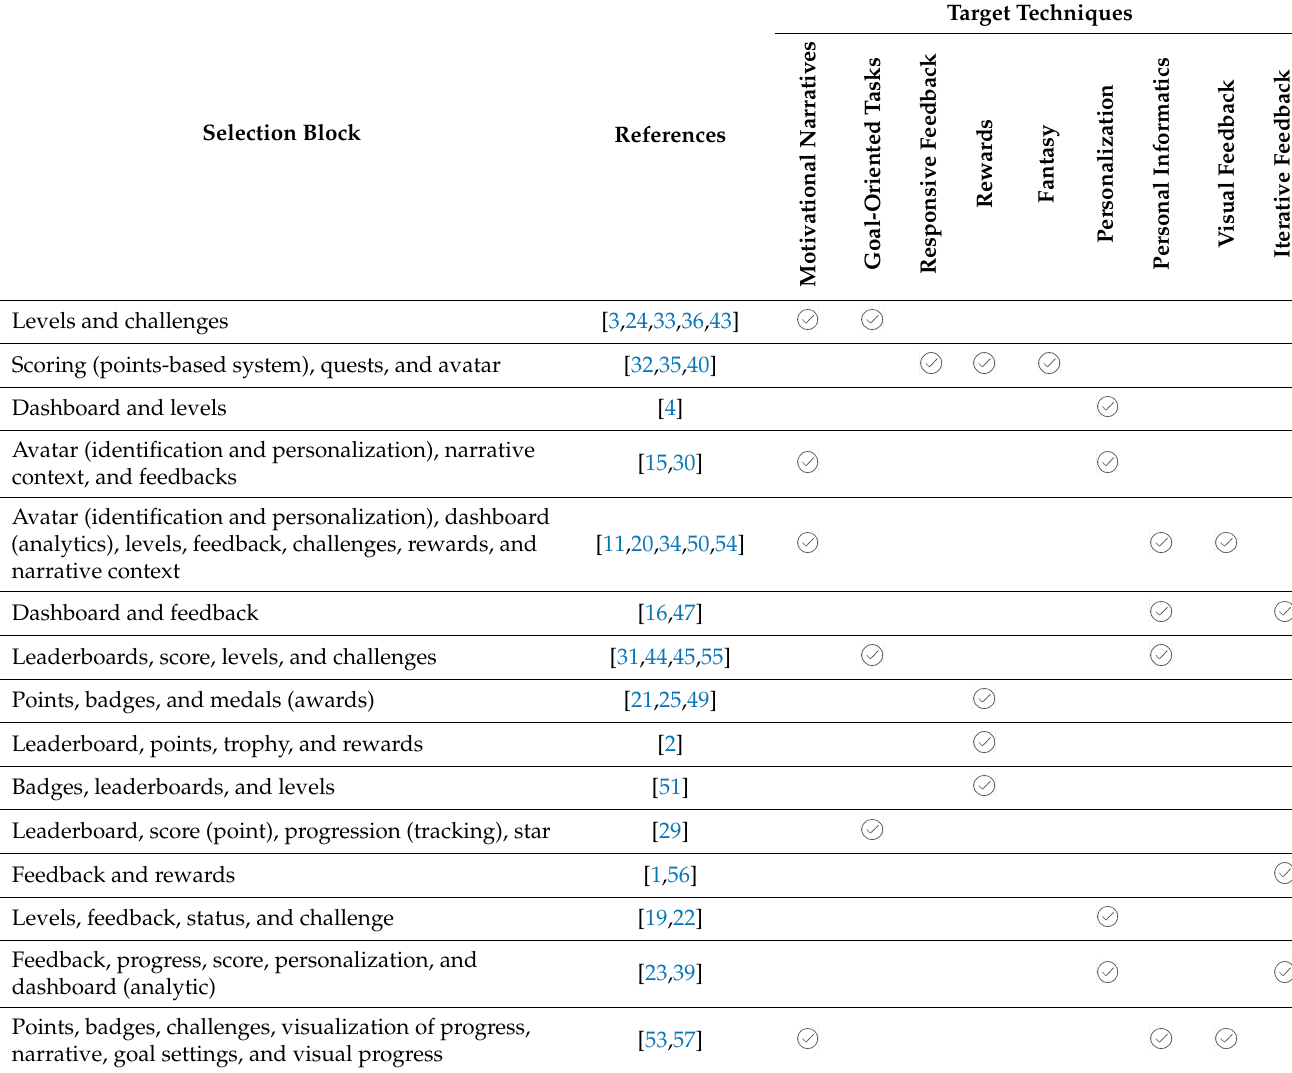
Table 2. Selection of building blocks used in rehabilitation